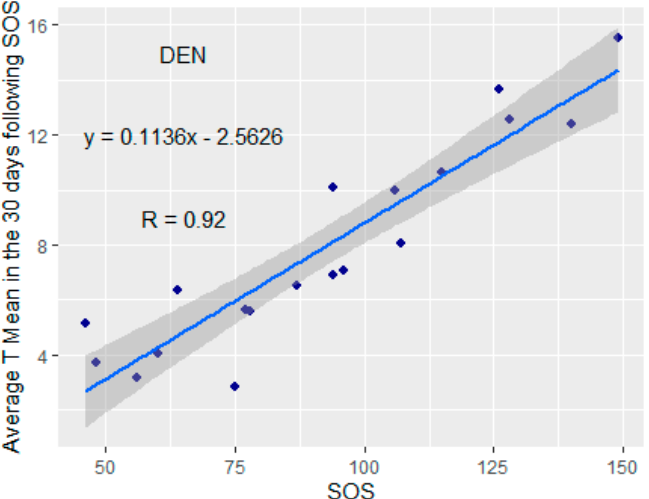
Figure 9. Example of relationships between SOS and the mean temperature of the 30 days after SOS at the DEN site.